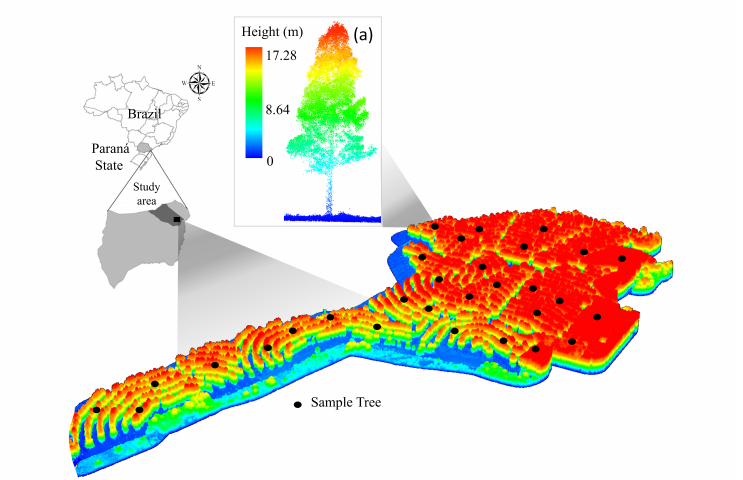
Figure 1. Location of the study area in Southern Brazil with the UAV-LiDAR 3D point Cloud and the 30 selected sample trees (black points) for QSM application: ( a ) Detail of the normalized point cloud of a selected